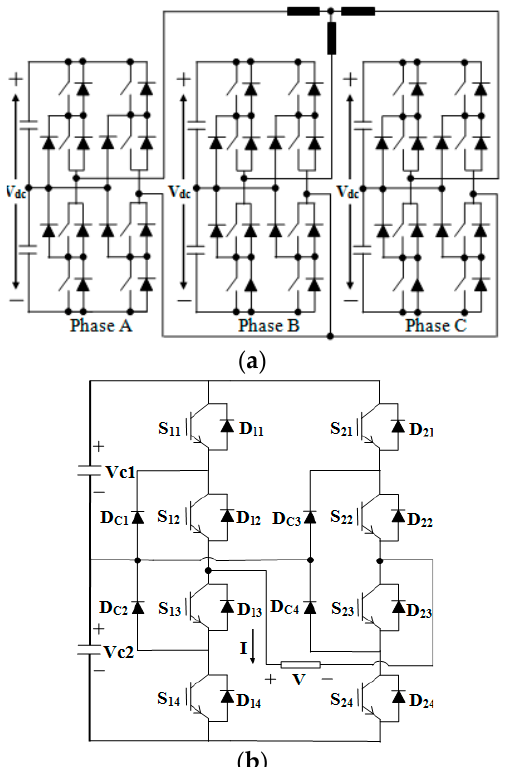
Figure 1. Scheme of ( a ) a three-phase five-level NPC/H-bridge inverter, and ( b ) a single-phase five-level NPC inverter.